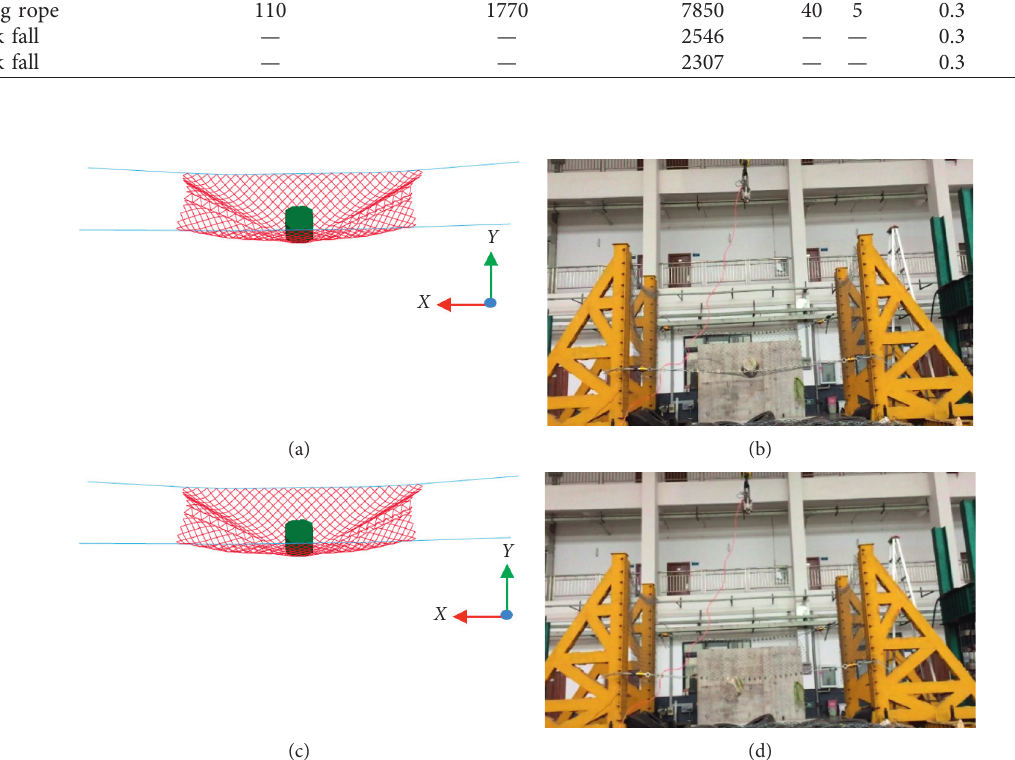
Figure 7: The comparison between numerical simulation and experiment of XT-2.5-50-3. (a) Maximum deformation of simulation. (b) Maximum deformation of experiment. (c) The falling rocks were ejected. (d) The falling rocks were